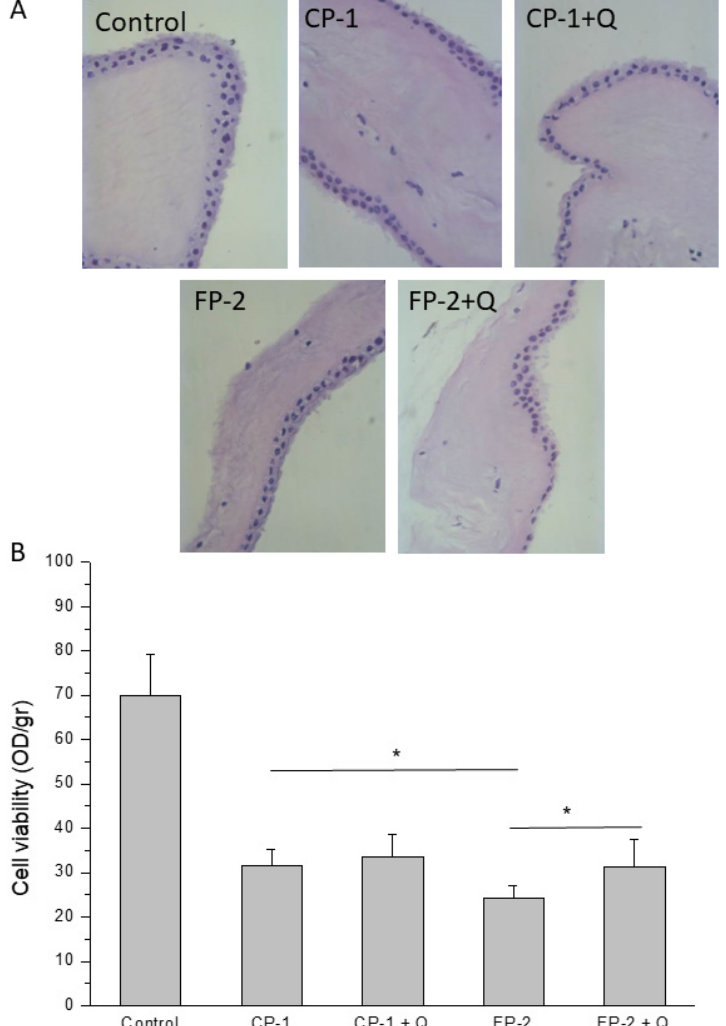
Figure 4. ( A ) Histological evaluation immediately after thawing of HAM preserved with cryopreservation protocol 1 (CP ‐ 1) (upper, central panel) or with CP ‐ 1 in the presence of quercetin (CP ‐ 1 + Q, upper right panel) and HAM preserved with freezing protocol 2 (FP ‐ 2) (lower, left panel) or with FP ‐ 2 in the presence of quercetin (FP ‐ 2 + Q, lower right panel). Untreated and not preserved HAM was used as control (upper, left panel). ( B ) MTT viability test on fresh not preserved HAM tissues (Control) and thawed HAM samples preserved with CP ‐ 1 or FP ‐ 2 in the presence (CP ‐ 1 + Q and FP ‐ 2 + Q) or not (CP ‐ 1 and FP ‐ 2) of quercetin. Data are represented as the mean of OD/gr ratio ± SD of 3 independent experiments. * p < 0.05 between the indicated bars.